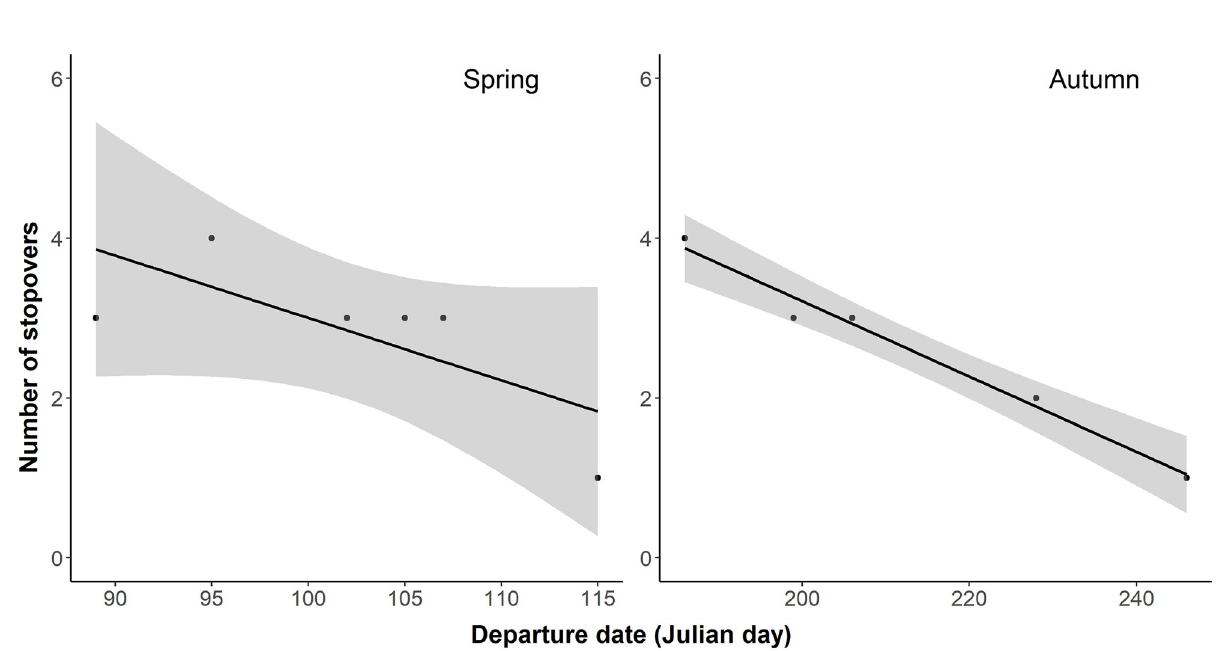
Fig 6. The number of stopovers in relation to spring and autumn departure dates. The lines show the estimates for the effect of departure dates on number of stopovers, and gray areas reflect the 95% confidence intervals for the estimates.